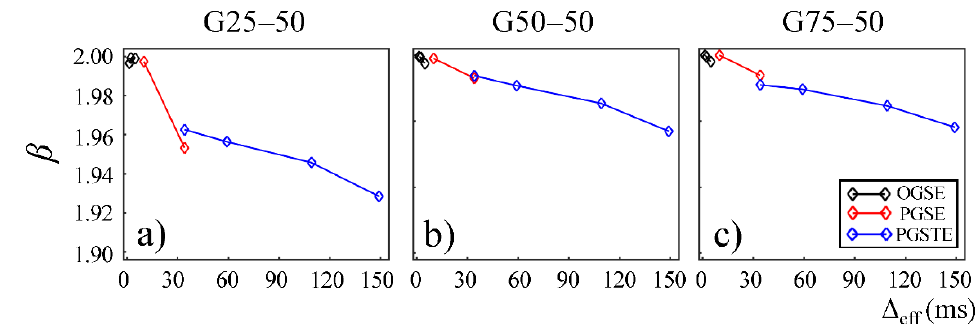
Figure 5. Plots of spatial fractional order ( β ) versus effective diffusion time, Δ eff , for gels G25 – 50 ( a ) and G50 – 50 ( b ), and G75 – 50 ( c ). The data acquired by using the OGSE, PGSE, and PGSTE pulse sequences are marked in black, red, and blue, respectively.